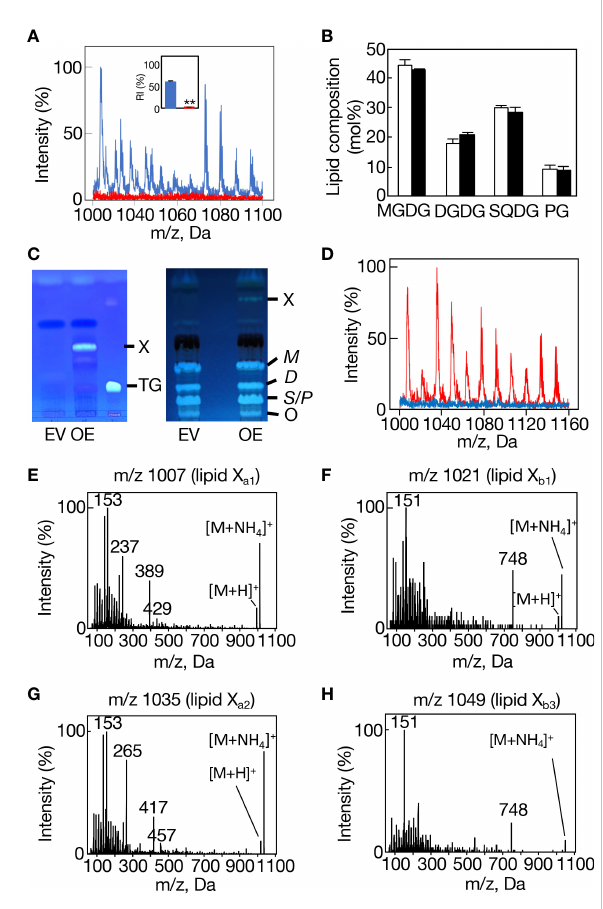
FIGURE 4 Loss-of-function and gain-of-function analyses of slr2103 . (A) MS spectrum of a lipid fraction (retention time of 15-17 min, m/z 1000- 1160), including lipid X, on LC-MS analysis of total lipids prepared from WT cells (blue) or D slr2103 ones (red). The signal intensity of m/z 1007 relative to a total lipid fraction (retention time of 2-18 min, m/z 200- 1200) in the WT was adjusted to 100%. Inset, the estimated relative signal intensity of the lipid X fraction. The WT value was adjusted to 100%. (B) Polar lipid composition of D slr2103 . White and black bars indicate the WT and D slr2103 , respectively. (C) TLC-pro fi les of a lipid X fraction with a solvent system of 100% toluene (left). The lipid X fraction in OE or its counterpart in EV, which was obtained through TLC of total lipids with a solvent system of hexane/diethyl ether/ acetate (70:30:1 by vol.), was then subjected to another TLC with a solvent system of 100% toluene. Note that OE but not EV showed lipid X that was quite distinct from a marker TG in mobility. The two- step TLC-pro fi les of total lipids (right). Note that the two-step TLC enabled not only separation of lipid X from polar lipids but also that of polar lipids into three fractions, MGDG ( M ), DGDG ( D ), and SQDG ( S ) +PG ( P ). (D) MS spectrum of the lipid fraction, including lipid X, on LC- MS analysis of total lipids prepared from EV cells (blue) or OE ones (red), with the signal intensity of m/z 1007 in OE relative to the total lipid fraction adjusted to 100%. MS 2 spectrum of m/z 1007 (E) , m/z 1021 (F) , m/z 1035 (G) , or m/z 1049 (H)